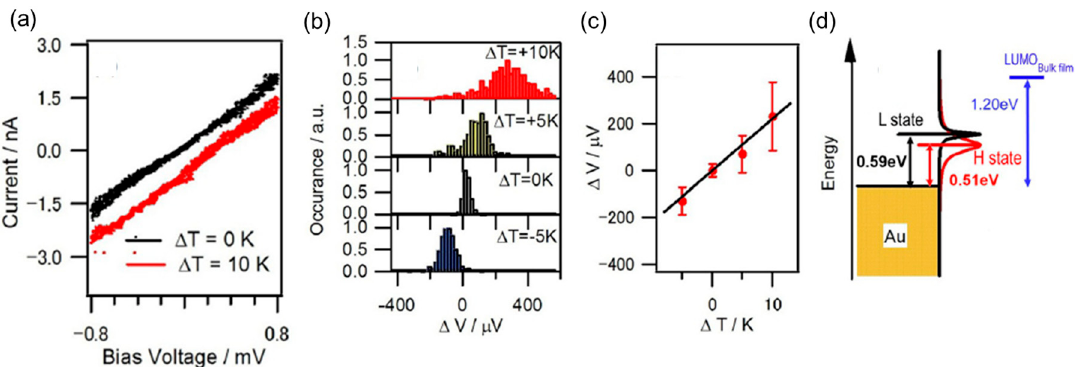
Figure 12. ( a ) Example of the I – V characteristics of the C 60 single-molecule junction at a temperature difference of 0 and 10 K. ( b ) Histograms of the thermoelectric voltage ( Δ V ) at temperature differences ( Δ T ) of − 5 K, 0, +5 K, and +10 K. ( c ) Plot of the peak values in the of the Δ V histogram as a function of